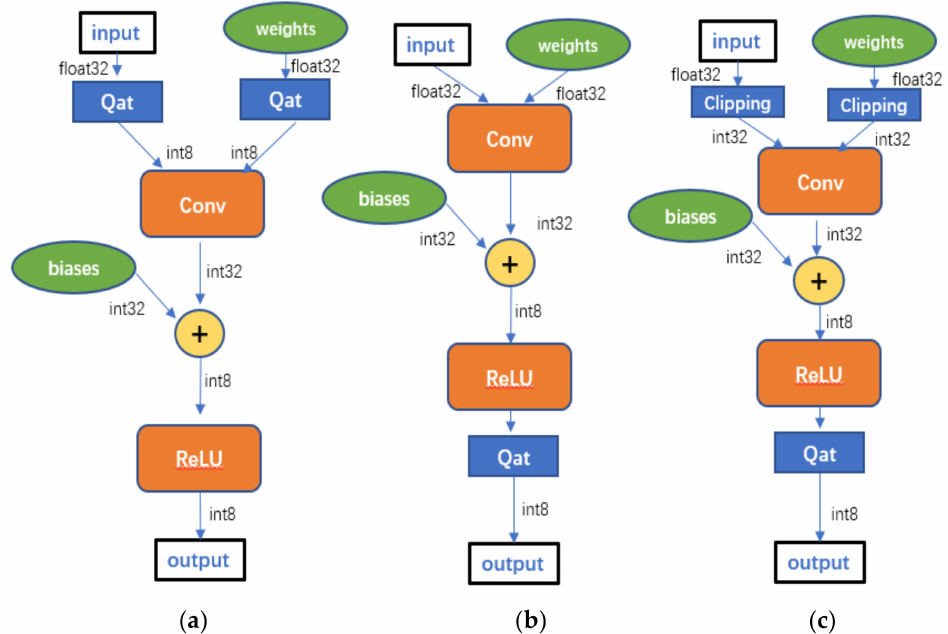
Figure 1. Demonstration of training-aware quantization, post-training quantization, and clipping- based post-training 8-bit quantization. ( a ) Training-aware quantization. Both input and weights are quantized and the model is trained the quantized to 8-bit number. ( b ) Post-training quantization. The input and weights are pseudo-quantized to 32-bit integer for training and further quantified after training. ( c ) Clipping-based post-training 8-bit quantization. The input and weights are pseudo- quantified and clipped to a predesigned range, and then further quantified after training. The basic ideas of the three strategies in Figure 1 are as